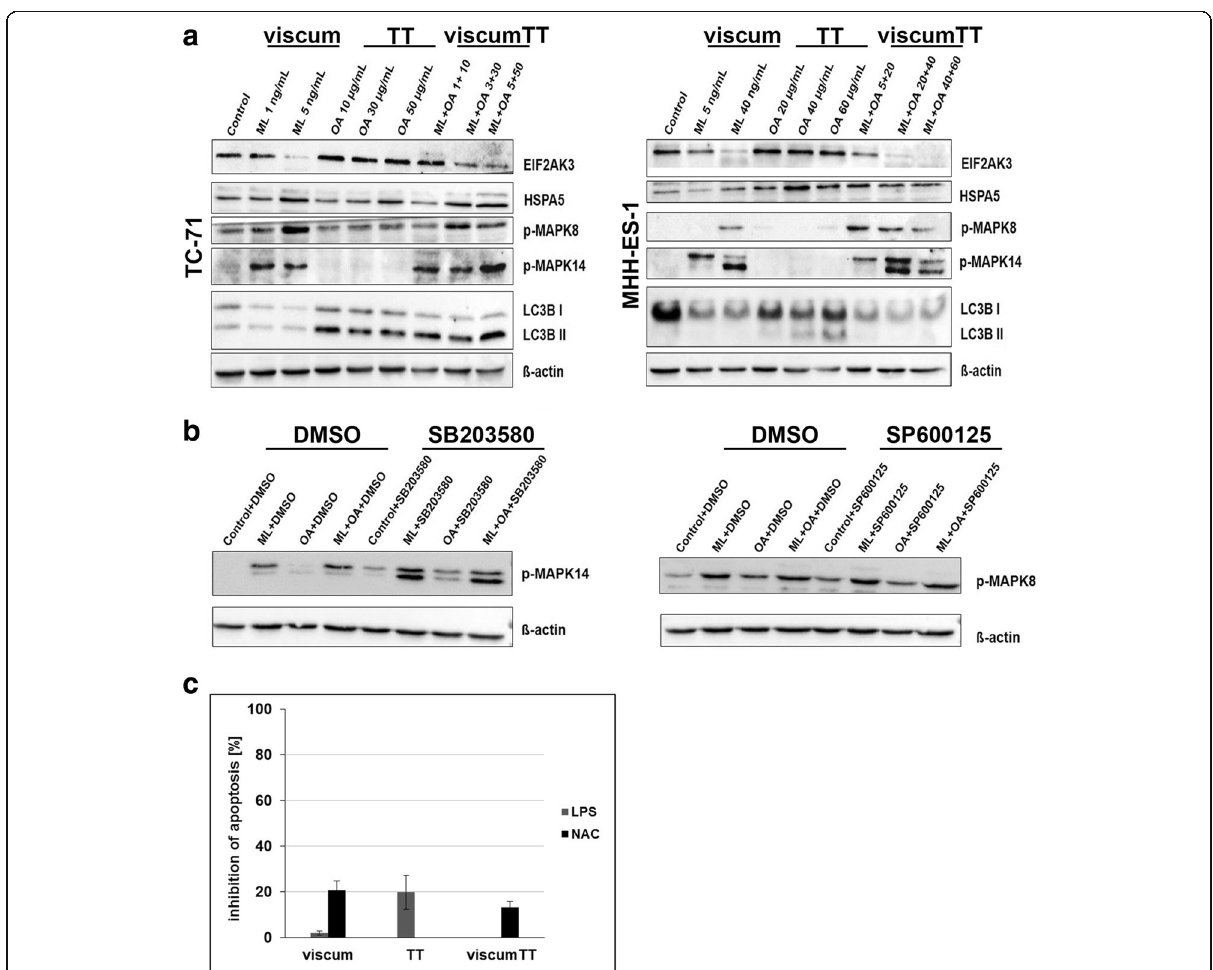
Fig. 4 ViscumTT induces cellular stress responses. a TC-71 and MHH-ES-1 cells were treated with increasing concentrations of viscumTT (ML-I 1 – 40 ng/mL + OA 10 – 60 μ g/mL), viscum (ML-I 1 – 40 ng/mL) or TT (10 – 60 μ g/mL) for 24 h. Activation of stress-mediated MAPK signalling (p-MAPK8, p-MAPK14), cellular stress/unfolded protein response (EIF2AK3, HSPA5) and autophagy (LC3BI/II) were assessed using western blotting. β -actin was